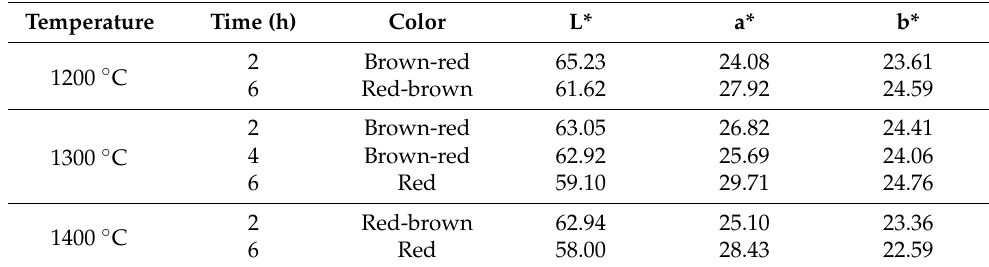
Table 5. Chromatic coordinates values of glazed tiles in the Y 0.98 Al 0.98 Cr 0.04 O 3 system at different firing temperatures and retention